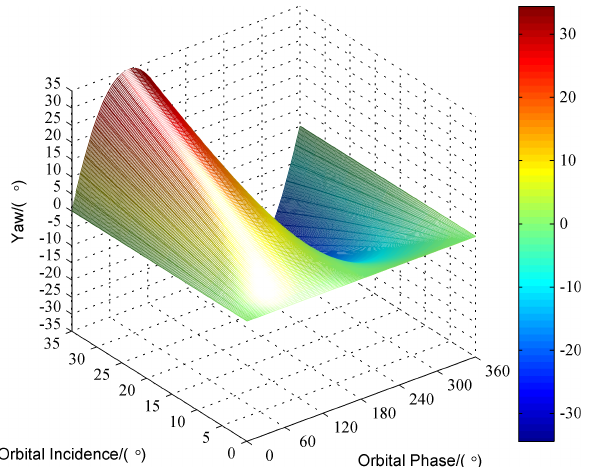
Figure 8. Simulations of the yaw angle